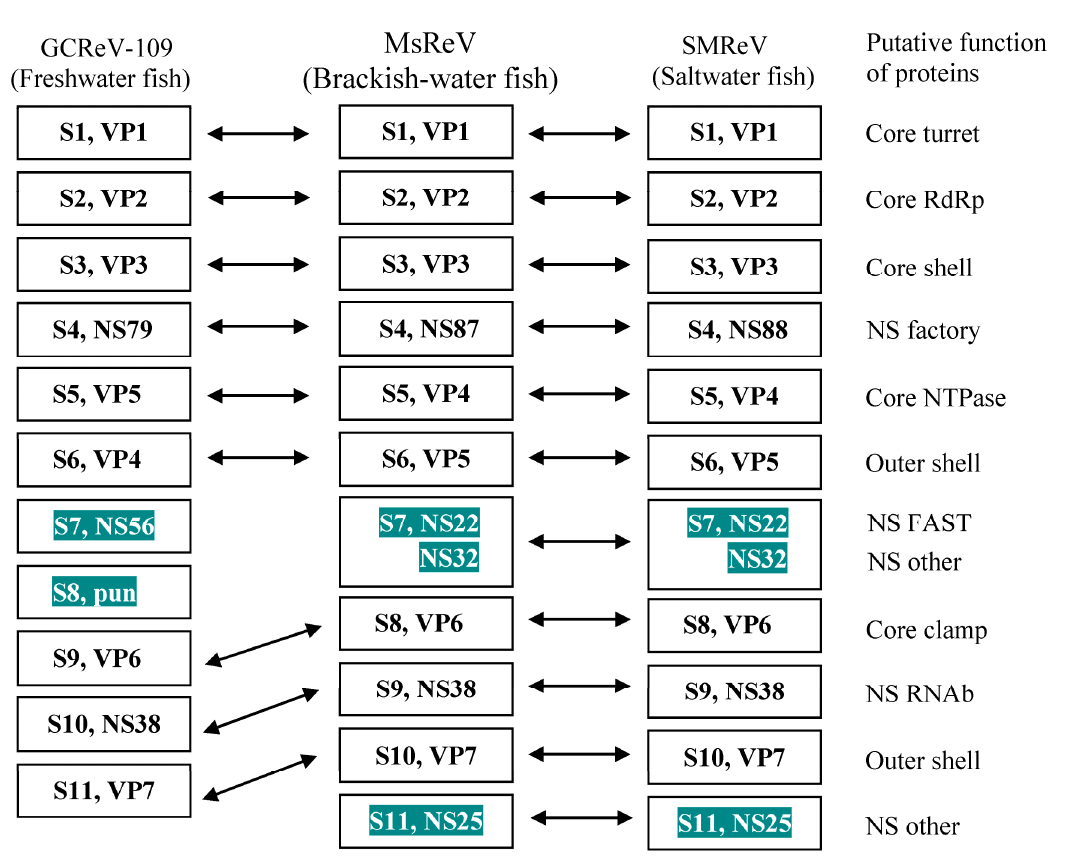
Figure 4. Equivalent genome segments and their encoding proteins among MsReV, SMReV and GCReV-109. Double-headed arrows indicate the equivalent segments and proteins. The shaded boxes show consistency between MsReV and SMReV (S7, NS22 and NS32; S11, NS25), but differences with GCReV-109 (S7, NS56; S8, pun). Pun, protein unknown function.